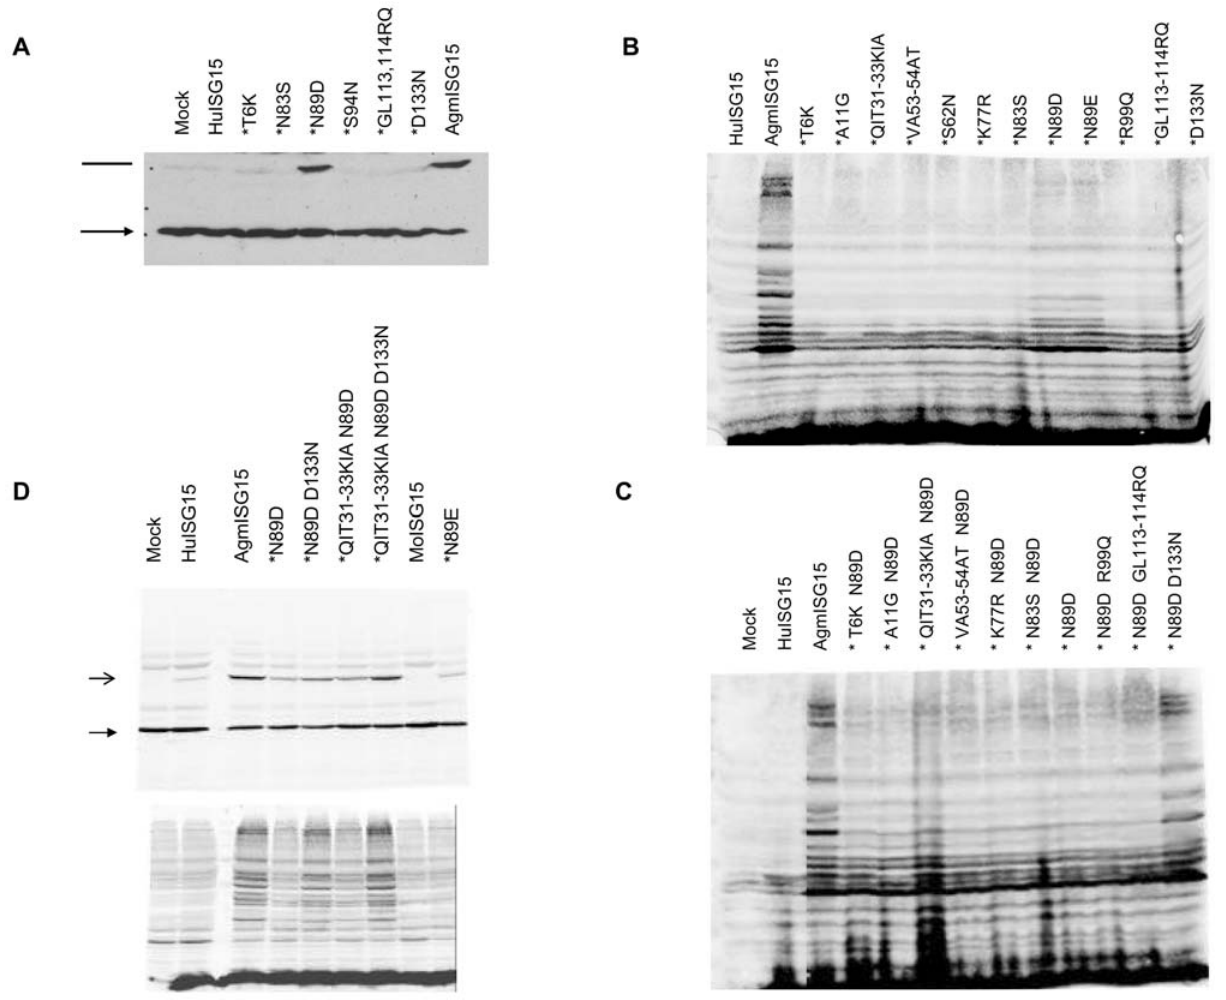
Figure 5. Mutation of residue 89 in HuISG15 to Asp greatly enhances its conjugation capacity, which could be further boosted by mutations of QIT31-33KIA and D133N. (A ) HuISG15 N89D mutant significantly increases its ISGylation capacity to UbcH proteins. HekT cells were transiently transfected with a vector encoding V5-tagged UbcH10 together with either empty vector or a vector expressing HuISG15 or variants (indicated with asterisk) or AgmISG15. Total cell lysates were prepared in a buffer containing b -ME. UbcH10 protein is revealed by its V5-tag. Closed arrow indicates the unconjugated form of UbcH10, open arrow indicates the ISG15-conjugated form of UbcH10. (B) Only mutation of residue 89 in wild type HuISG15 to an acidic amino acid is able to enhance its ISGylation activity. HekT cells were transiently transfected with vectors encoding the indicated FLAG-tagged HuISG15 variants (indicated with asterisk) each holding one amino acid substitution, FLAG-tagged wt Hu- or AgmISG15. Total cell lysates were prepared in a buffer with reducing agentia. The conjugation competence of the different ISG15 proteins is exposed by their FLAG- tag. Equal loading was confirmed by Ponceau S staining (not shown). (C) Additional mutation of QIT31-33KIA or D133N further boosts ISGylation by HuISG15 N89D. Same as (B) but with HuISG15 N89D variants with an additional amino acid substitution. (D) The triple HuISG15 QIT31-33KIA N89D D133N variant is as efficient as AgmISG15 in UbcH protein ISGylation. Upper panel . HekT cells were transiently transfected with a plasmid encoding V5-tagged UbcH17 protein together with either an empty vector or a vector expressing FLAG-tagged Hu-, Agm-, MoISG15 or a HuISG15 variant (with asterisk). Western blot analysis on total cell lysates was performed under reducing conditions using anti-V5 Ab. Closed arrow indicates the unconjugated form of UbcH17, open arrow indicates the ISG15-conjugated form of UbcH17. Lower panel The blot was stripped and reprobed with anti-FLAG Ab showing the global ISGylation pattern. Equal loading was controlled by staining with Ponceau S staining (not shown).